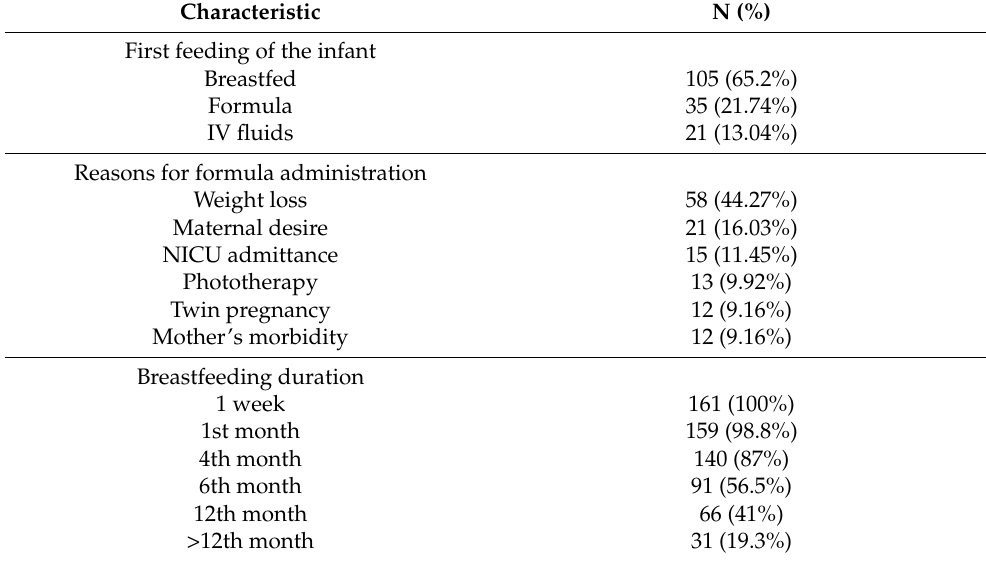
Table 4. Nutrition characteristics of the studied